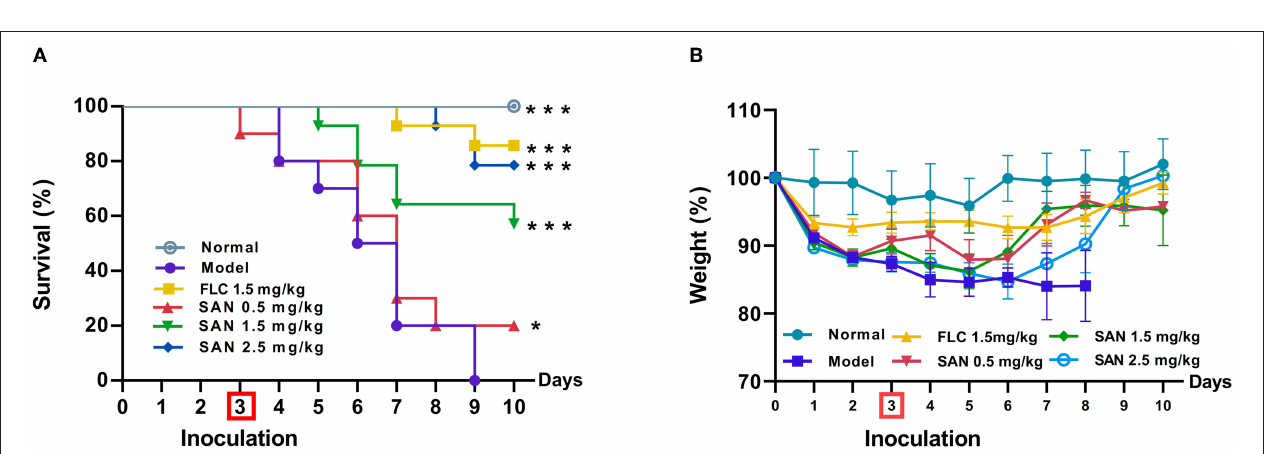
FIGURE 5 | Survival (A) and body weight change (B) of immunocompromised mice infected with C. albicans at 1 × 10 8 CFU/mL. Animals were treated for 10 days with water (normal group without infection; infection model group), fluconazole (FLC, 1.5 mg/kg/d), and SAN (0.5, 1.5, and 2.5 mg/kg/d, respectively). The results are displayed as means ± SEM from three independent experiments. * p < 0.05/*** p < 0.001 vs. model.